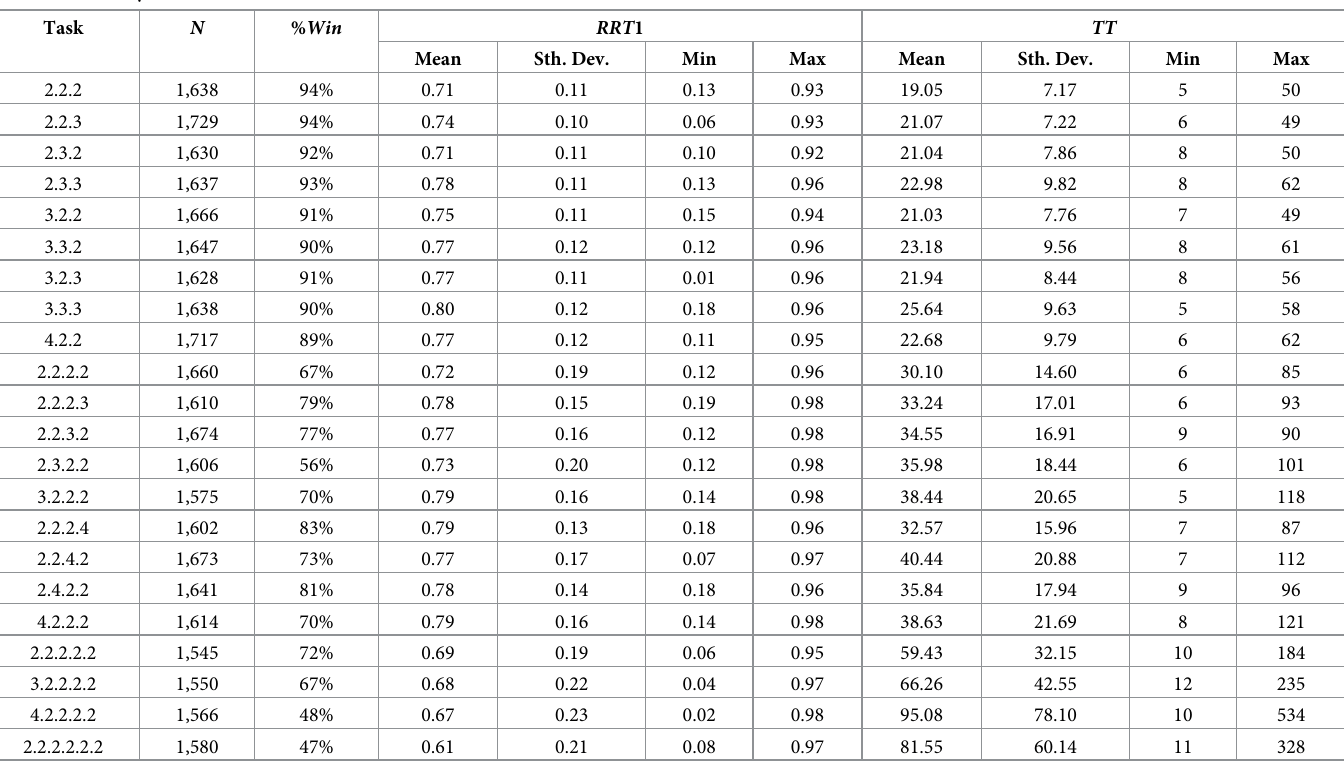
Table 1. Summary